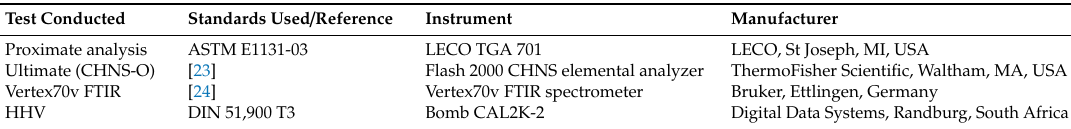
Table 2. Standard compositional and thermal analyses and the instruments used. HHV: high heating value and TGA: thermogravimetric